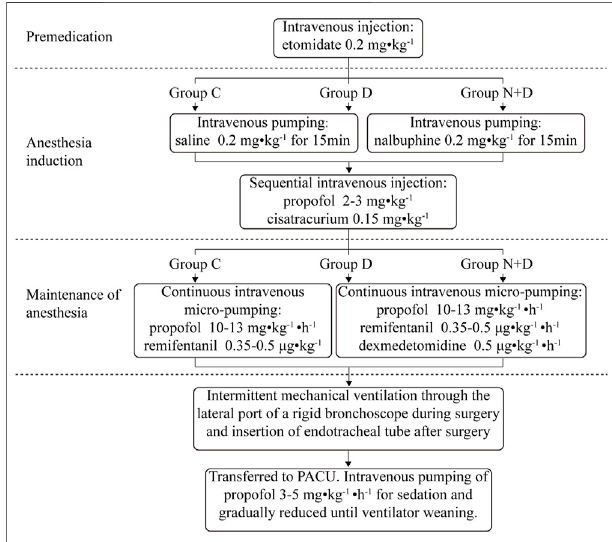
FIGURE 1 | Detailed anesthesia method for the removal of the foreign body under rigid bronchoscopy. All patients sequentially underwent the procedures of premedication, anesthesia induction, maintenance of anesthesia, and anesthesia recovery. During the premedication procedure, nalbuphine was administered in group N + D; an equal amount of normal saline was administered in group D and group C. During anesthesia maintenance, group N + D and group D received dexmedetomidine until the end of the operation and group C received an equal amount of normal saline for